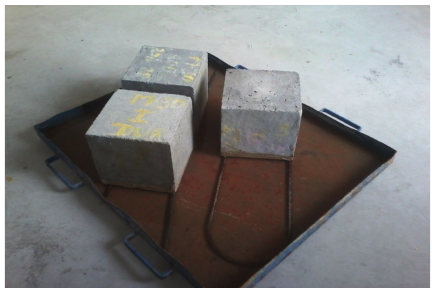
Figure 5: Alkalinity